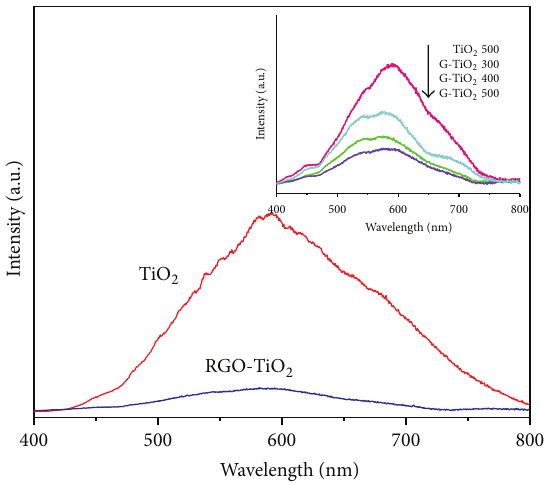
Figure 7: PL spectra of the as-prepared TiO 2 and RGO-TiO 2 composite. The inset shows the PL spectra of fabricated TiO 2 and various G-TiO 2 electrodes.